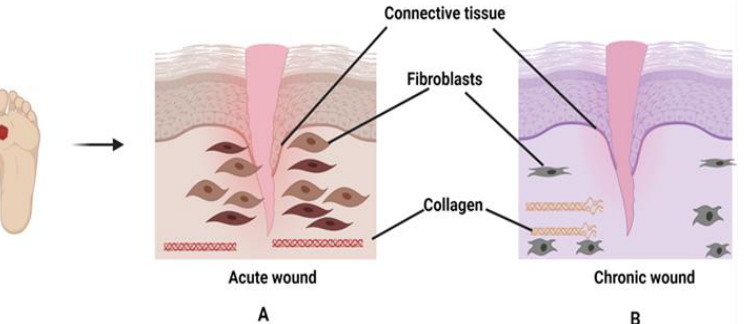
Figure 2. Diagram ( A ) shows the normal morphological structure of fibroblasts in an acute wound. In Diagram ( B ), the fibroblasts become senescent, reduce in numbers, inhibit migration to the wounded site, and alter collagen synthesis.